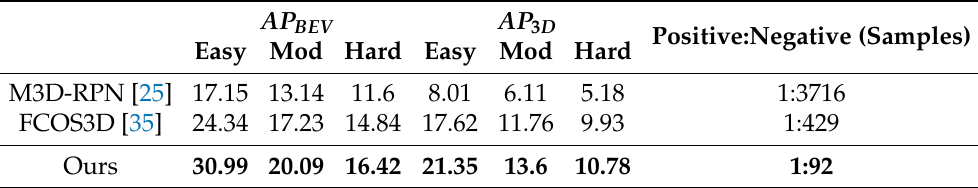
Figure 15. The effect of σ , γ and N t on the AP for the density-based soft NMS by applying Bayesian optimization. We first optimize σ and N t in the 3D soft NMS, and then optimize γ in the density-based Soft NMS. Table 6. The comparison of AP 40 among our positive samples’ assignment strategy, the strategy of M3D-RPN, the strategy of FCOS3D on the Bird’s Eye View object detection task, and 3D object detection task on the KITTI validation set. We use bold type to indicate the best result.